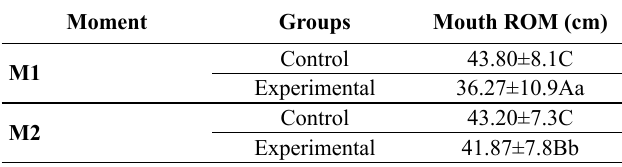
Table 2. Descriptive values on maximal mouth-opening range of mo- tion in the respective groups and the assessed